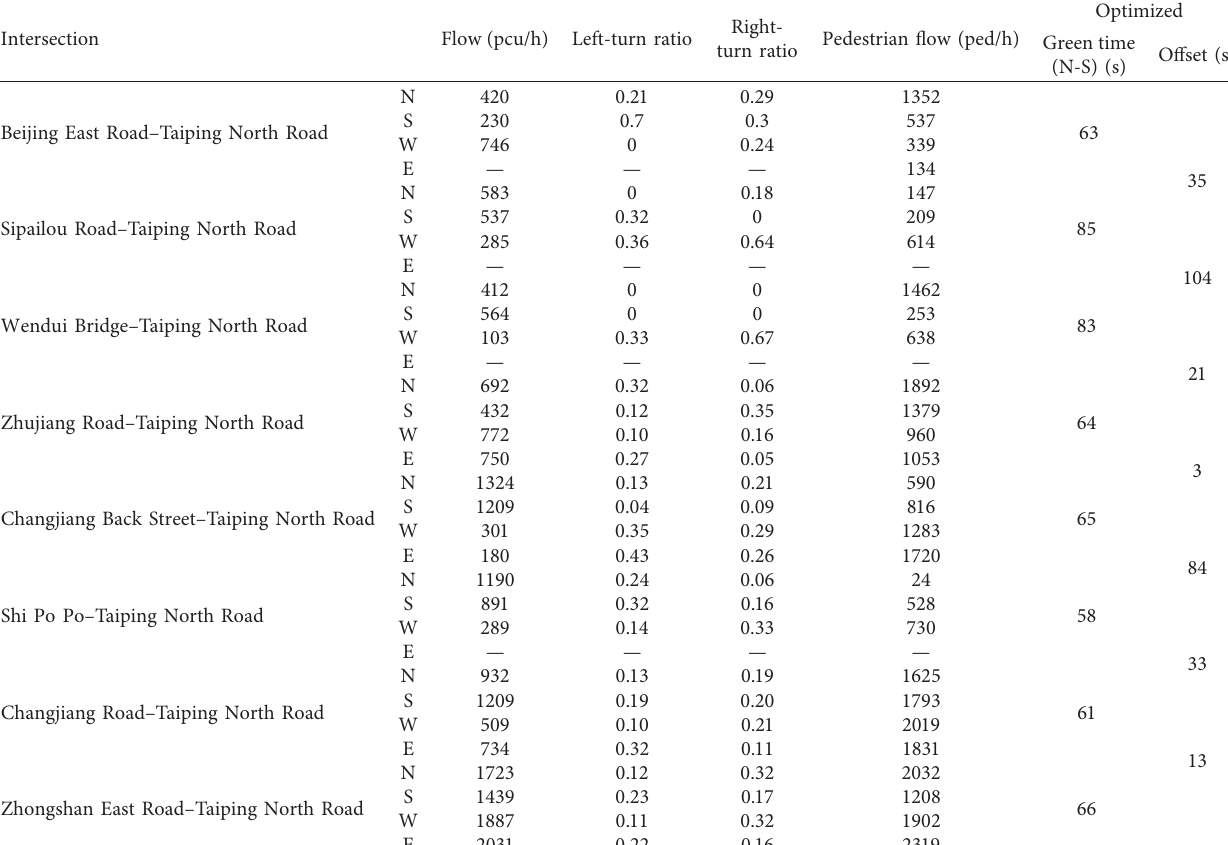
Table 3: Data of intersection and optimized